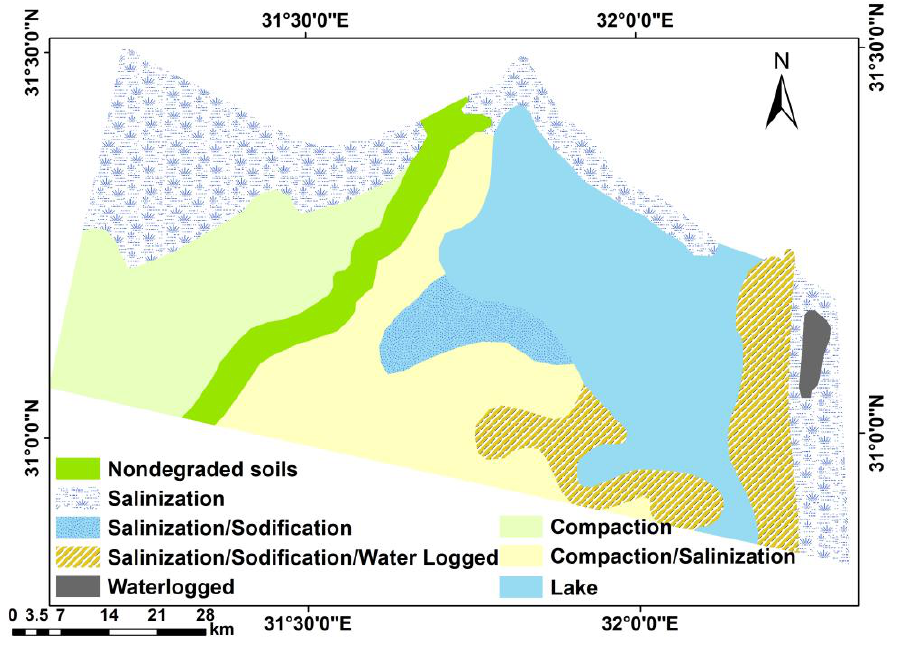
Figure 6. Degradation risk of the region.